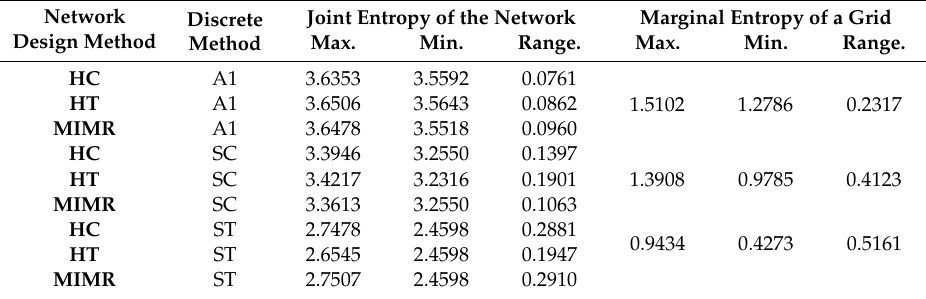
Table 1. Statistics on the range of